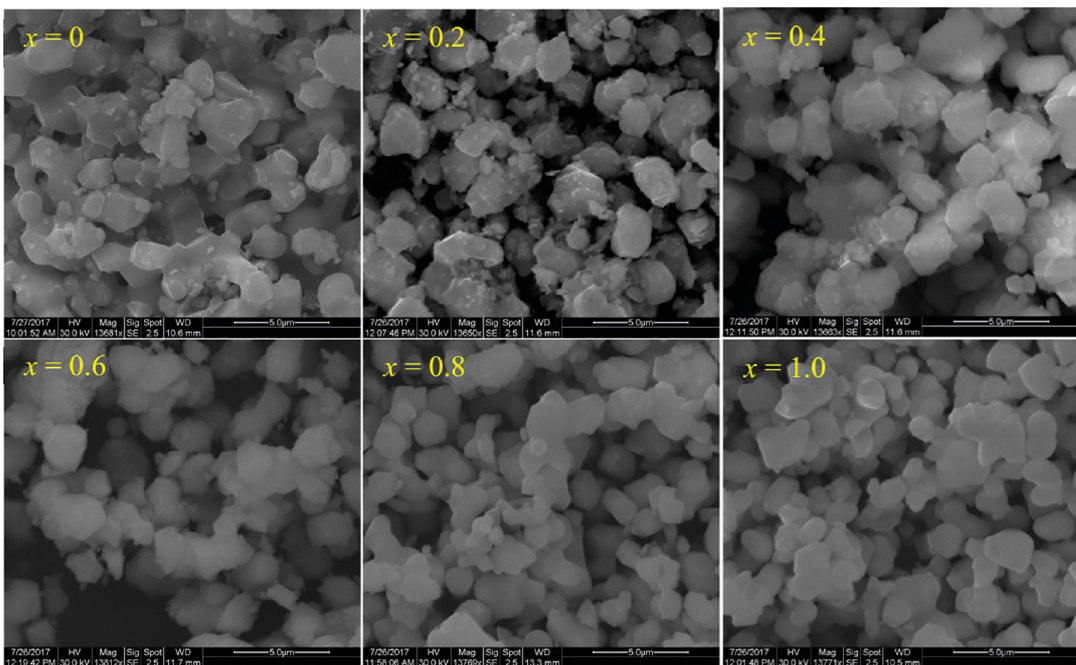
Figure 3. SEM images for all synthesized garnet samples.